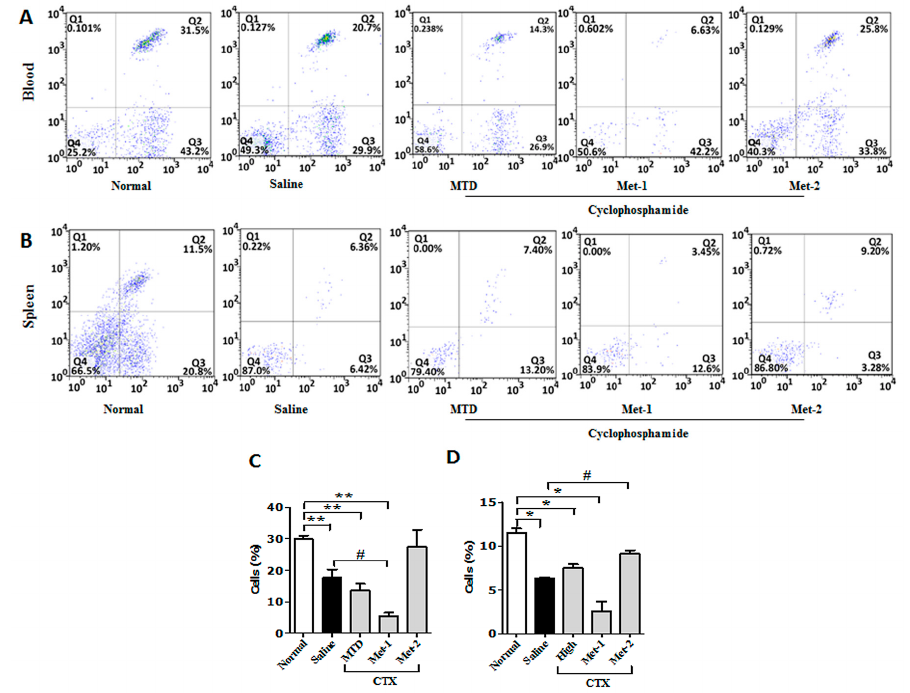
Figure 5. CD3 + / CD8 + T cells in blood ( A , C ) and spleen ( B , D ) from each group at the end of the observation period were measured by flow cytometry analysis. Fresh blood was collected in EDTA tubes and flow cytometry analysis was performed as described previously. “*” versus normal group and “#” versus saline group. * p < 0.05, # p < 0.05, ** p < 0.01.